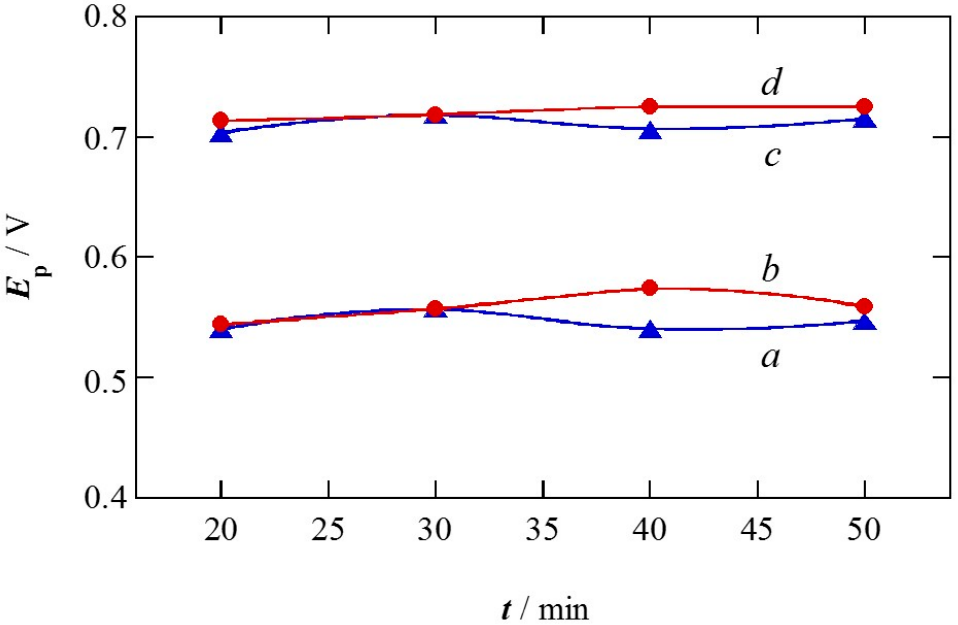
Figure 6. CO stripping peak potentials as a function of the immersion time in the Pt(IV) solution following the sequence ii (spontaneous deposition of the Ru species for 30 min, curves a and c ) and in the Ru(III) solution following the sequence iii (galvanic exchange with Pt(IV) species for 30 min, curves b and d ). Curves a and b refer to Pt-Ru(Cu)/C and curves c and d , to Pt(Cu)/C. In all cases, q Cu was of 38 mC.